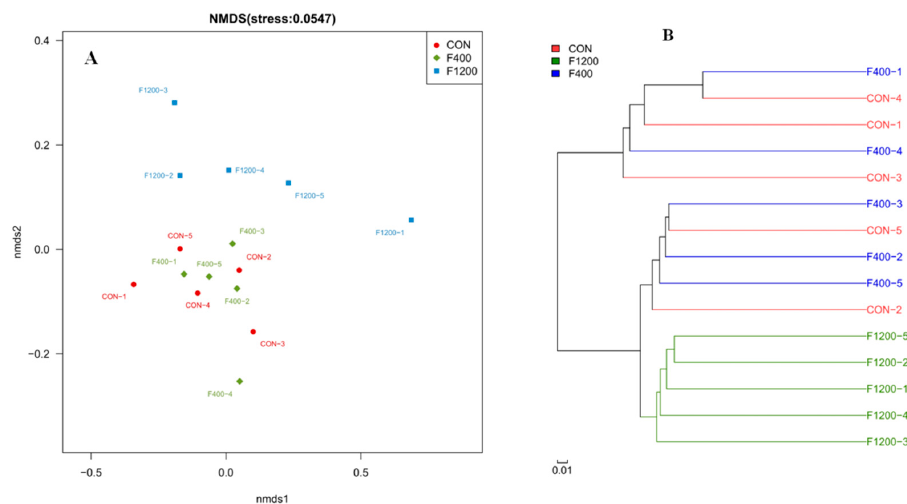
Figure 6. Effects of dietary fluoride level on the beta diversity of cecal microbiota between groups ( n = 5). ( A ) nonmetric multidimensional scaling (NMDS) plot. ( B ) Clustering analysis. CON, the control group, basal diet; F400 and F1200, diets supplemented with 400, and 1200 mg F/kg feed from sodium fluoride, respectively